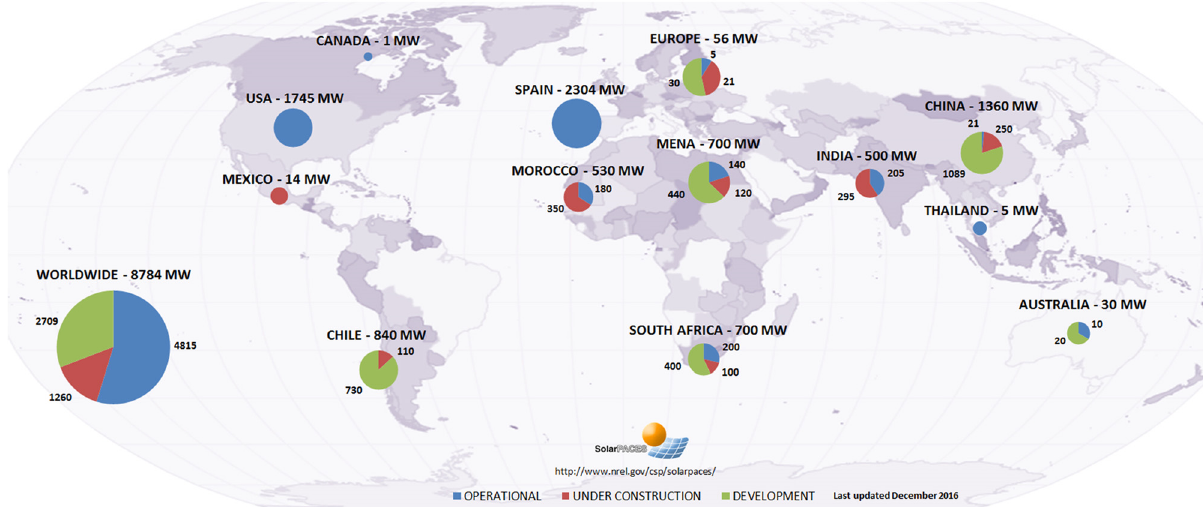
Figure 21: Concentrating solar power plants around the world. ( Retrieved from the SolarPACES website: www.solarpaces.org.